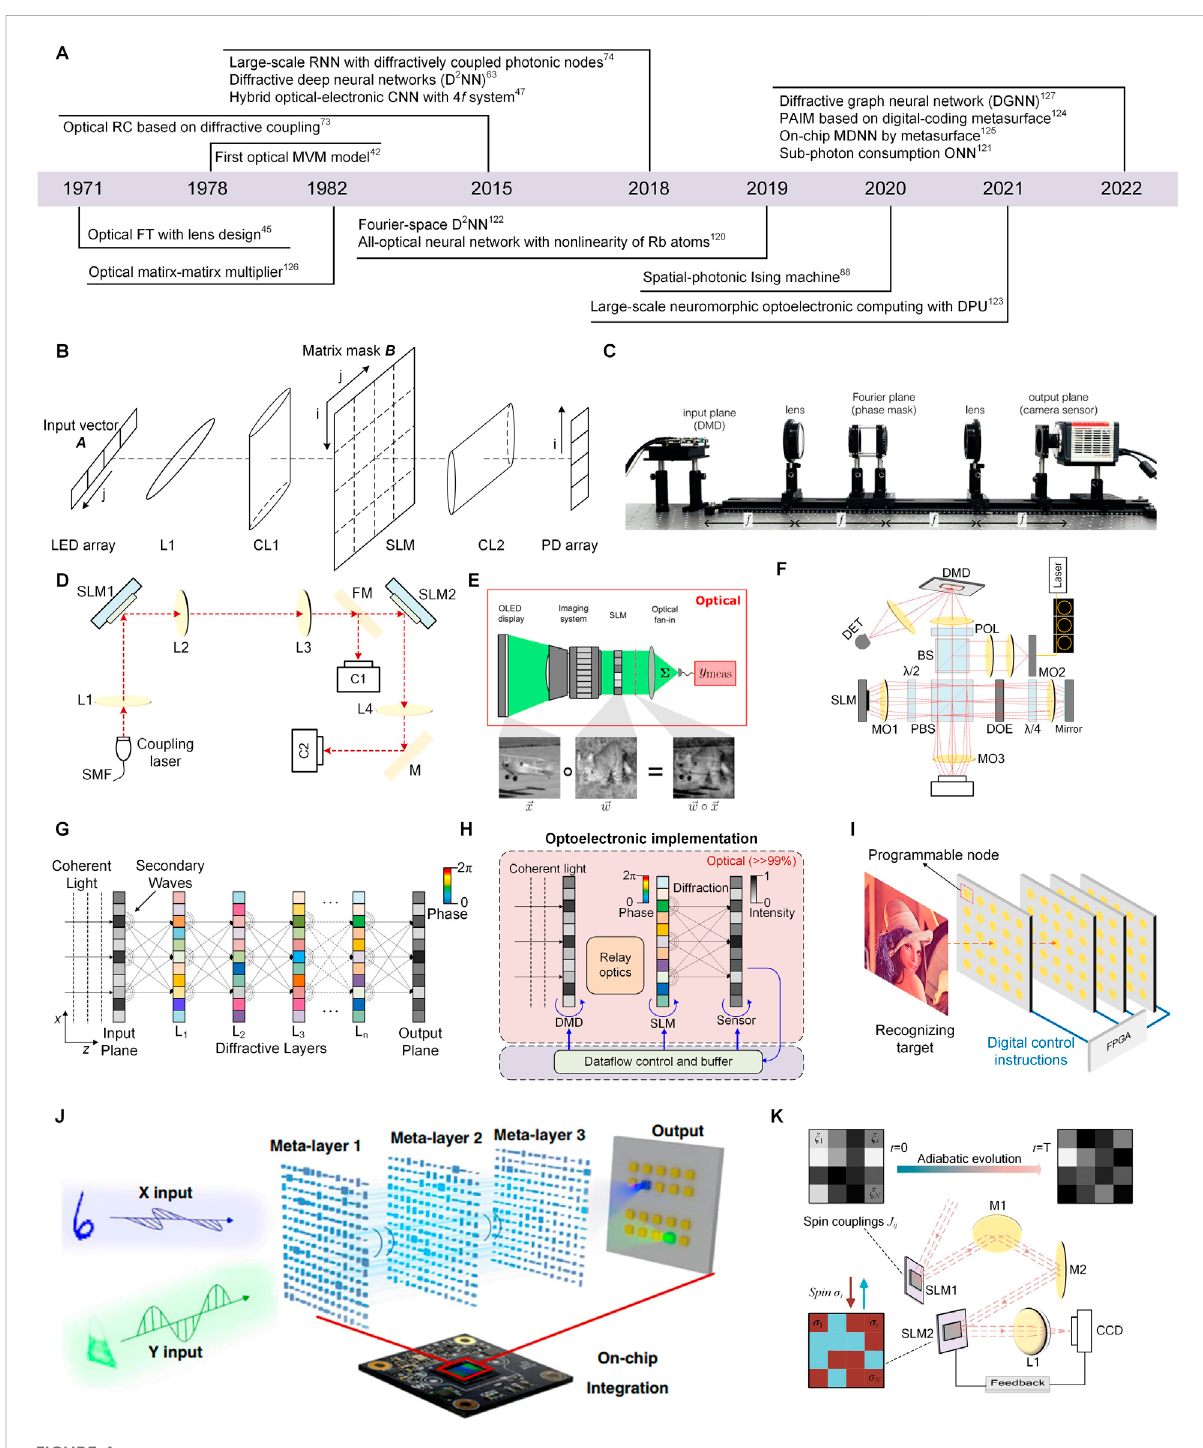
FIGURE 4 (A) The progresses of analog optical computing in the space-propagation optical platform. (B) Schematic of the optical MVM model. (C) Schematicof theoptical convolutional layer based on 4f system [47]. (D) Schematicof the linear operation inthe all-optical neural network [120]. (E) The procedure for characterizing optical vectorvector dot products [121]. (F) Schematic of the optical recurrent neural network using SLM and DOE [74]. (G) Schematicofthediffractivedeep neural network [63]. (H) Schematic of therecon fi gurable diffractiveprocessing unit(DPU) [123]. (I) An arrayofprogrammablemetasurfacesforconstructingtheprogrammablearti fi cialintelligencemachine[124]. (J) Theworkingprincipleoftheonchip multiplexed diffractive neuralnetwork[125]. (K) Principle ofthespatial-photonic Isingmachine[88]. (C) ReprintedfromRef.47withpermission from Springer Nature: Scienti fi c Reports. (E) Reprinted from Ref. 121 with permission from Springer Nature: Nature Communications. (J) Reprinted from Ref. 125 with permission from Springer Nature: Light|Science and